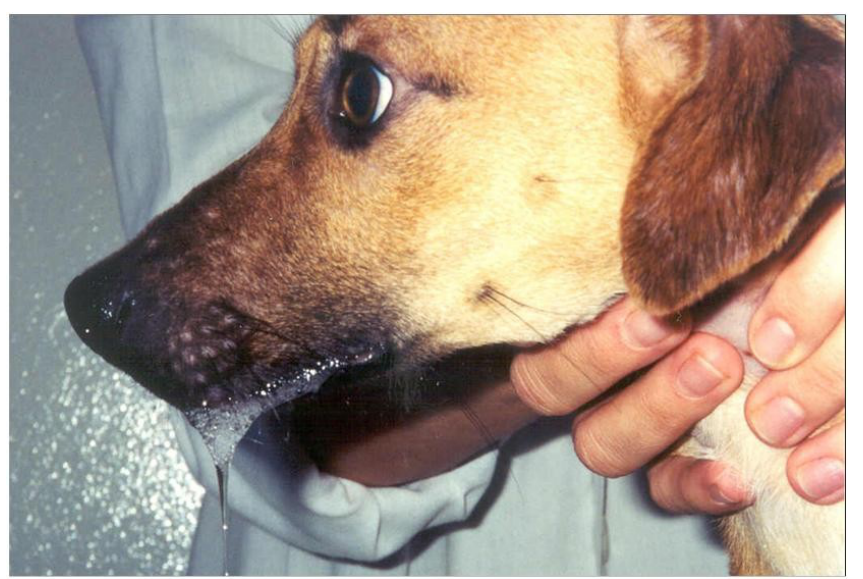
Figure 1. Animal from Group III presenting sialorrhea 6h after inoculation of crotalic venom.